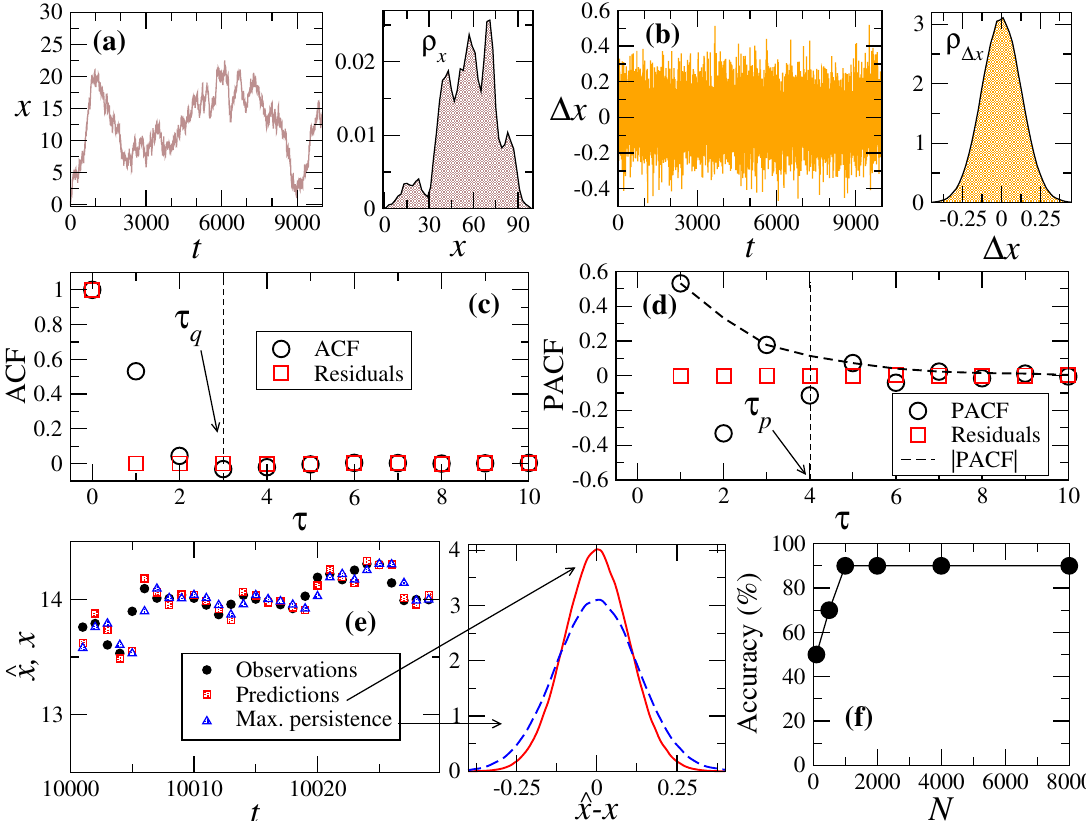
Figure 2. Illustration of an ARIMA model adaptation to a test series { x iterating Equation (1) for ( p , d , q ) = ( 2,1,2 ) with initial conditions x 0 = x 1 = 0. In ( a ), the series { x ( test ) } 1 ≤ t ≤ N is shown together with the corresponding histogram ρ t